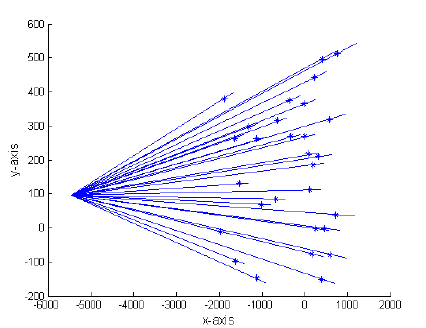
Figure 10. Image plane using correcetd EOPs